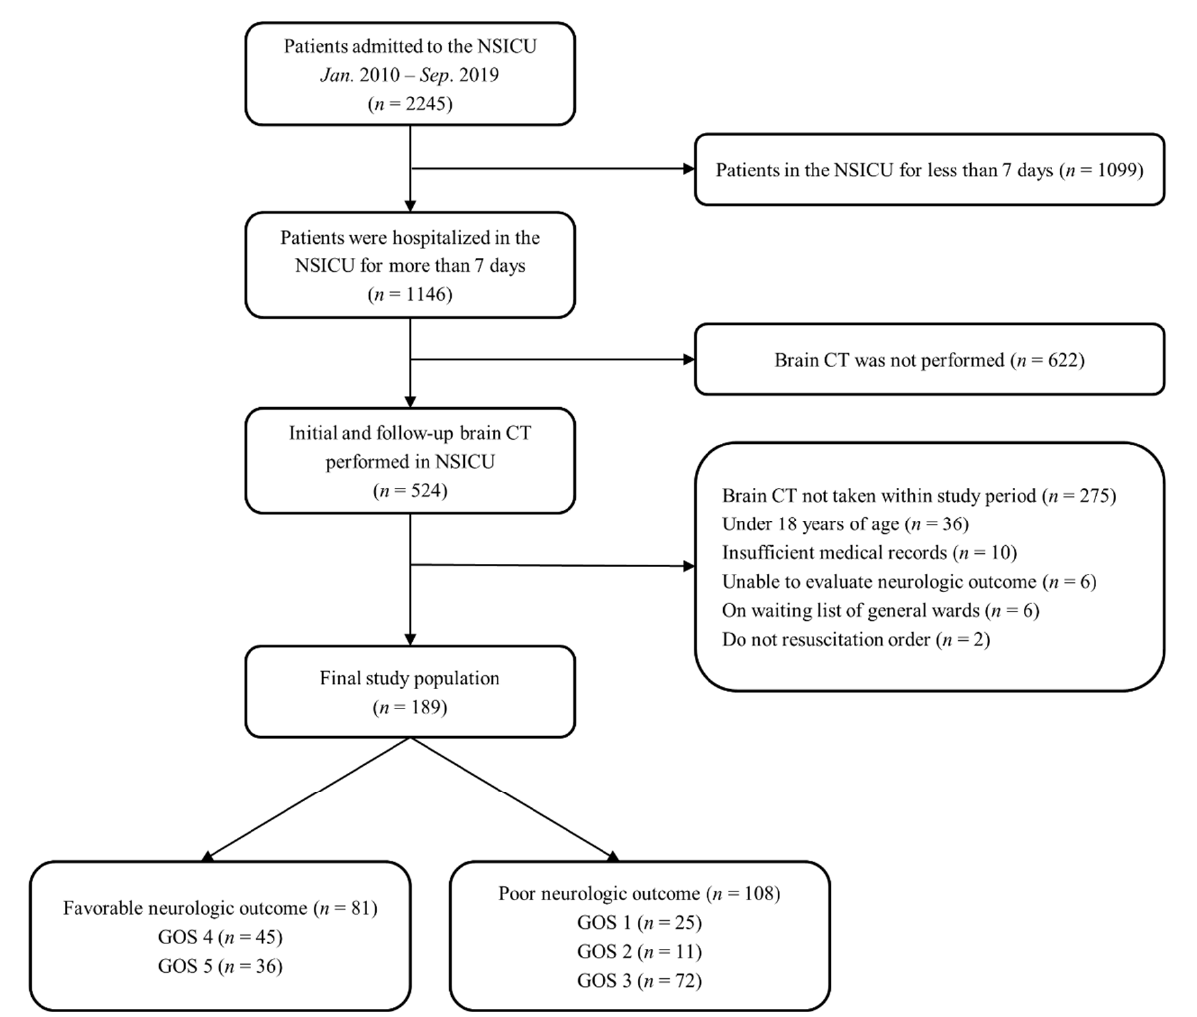
Figure 2. Study flow chart. NSICU, neurosurgical intensive care unit; CT, computed tomography; and GOS, Glasgow Outcome scale.